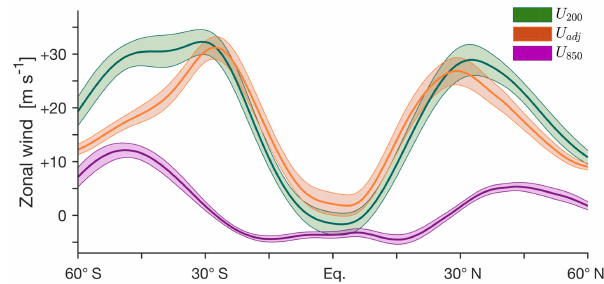
Figure 6. The zonally averaged annual-mean zonal wind at the 200 and 850hPa levels ( U 200 , green, and U 850 , purple) and the differ- ence between U 200 and U 850 ( U adj , orange). Data are taken from CMIP5 models for 1979–2004. The shading indicates ± 1 standard deviation of inter-model